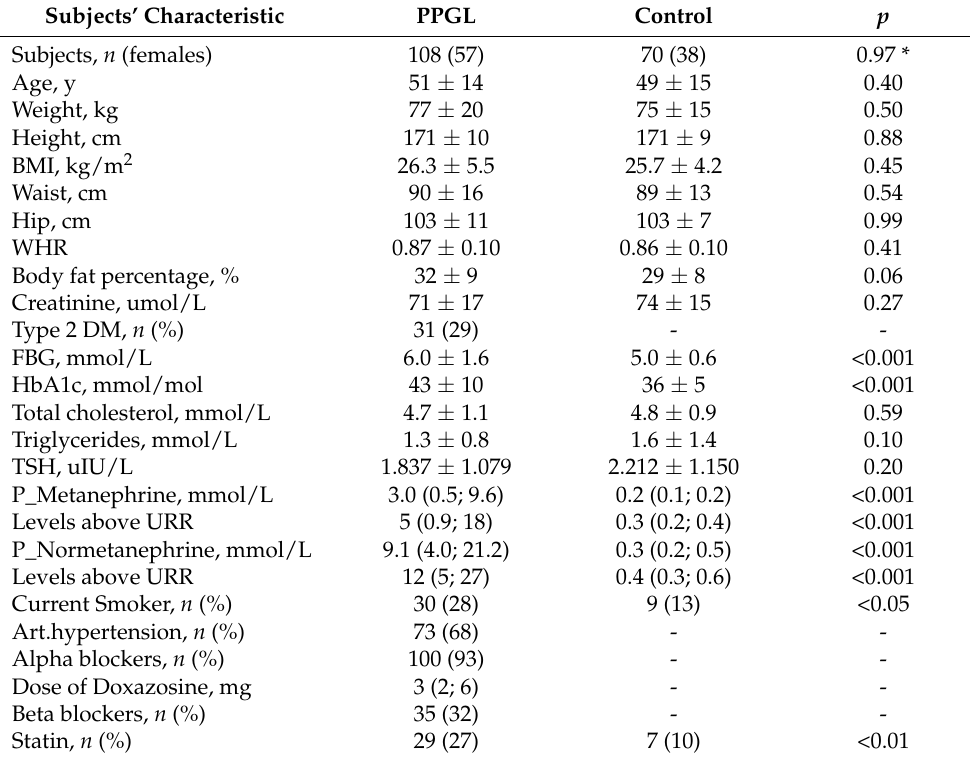
Table 1. Basic subject characteristics: PPGL and control